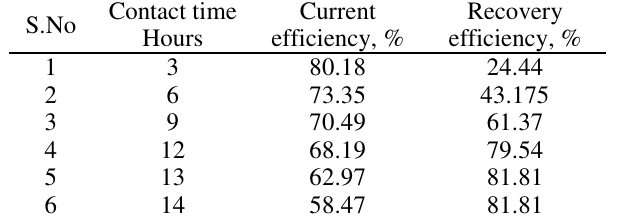
Table 6. Effect of contact time on current and recovery efficiency